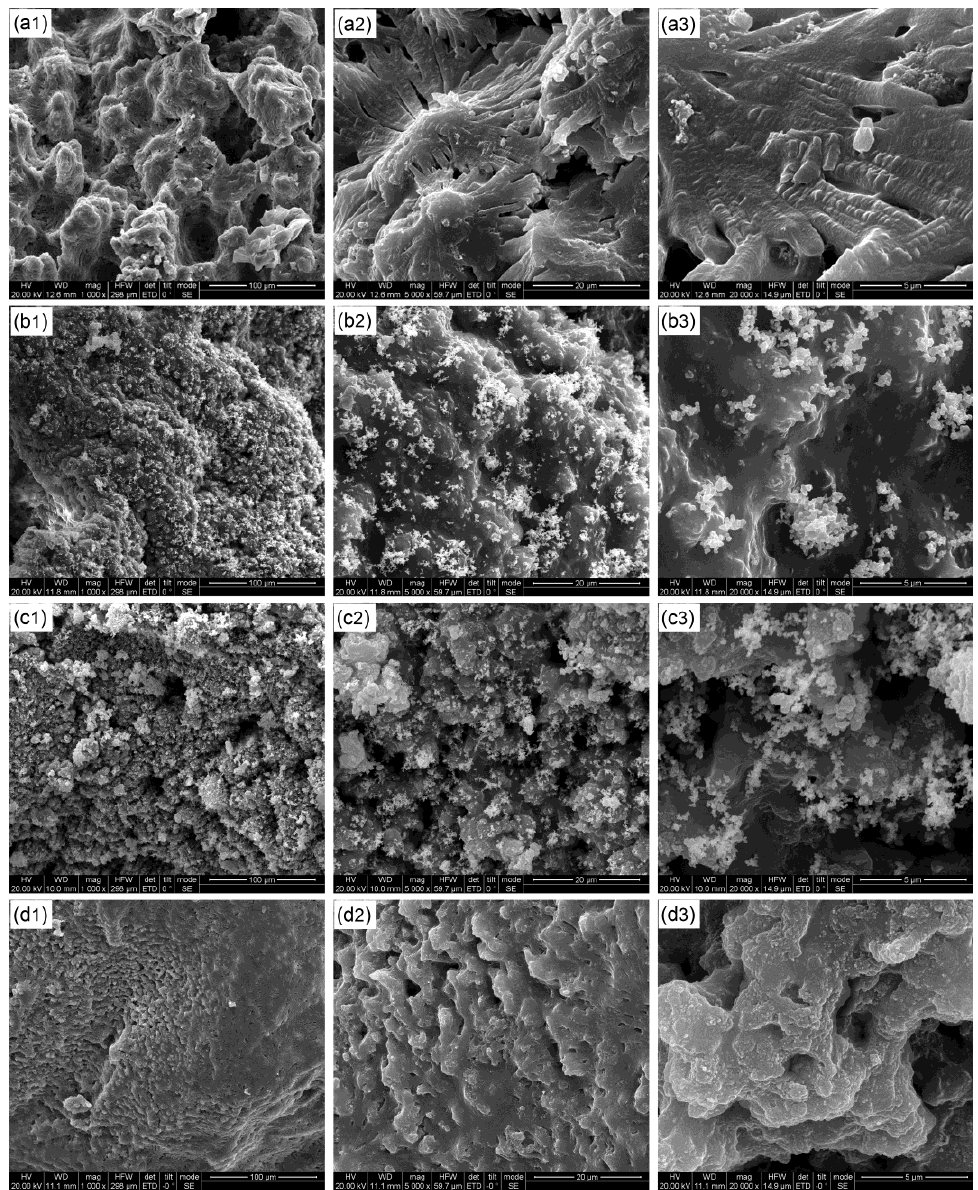
Figure 4. SEM images of the char residues after UL-94 tests for PP-3 ( a1 —1000 × , a2 —5000 × , a3 — 20,000 × ); PP-6 ( b1 —1000 × , b2 —5000 × , b3 —20,000 × ); PP-8 ( c1 —1000 × , c2 —5000 × , c3 —20,000 × ); PP-9 ( d1 —1000 × , d2 —5000 × , d3 —20,000 ×